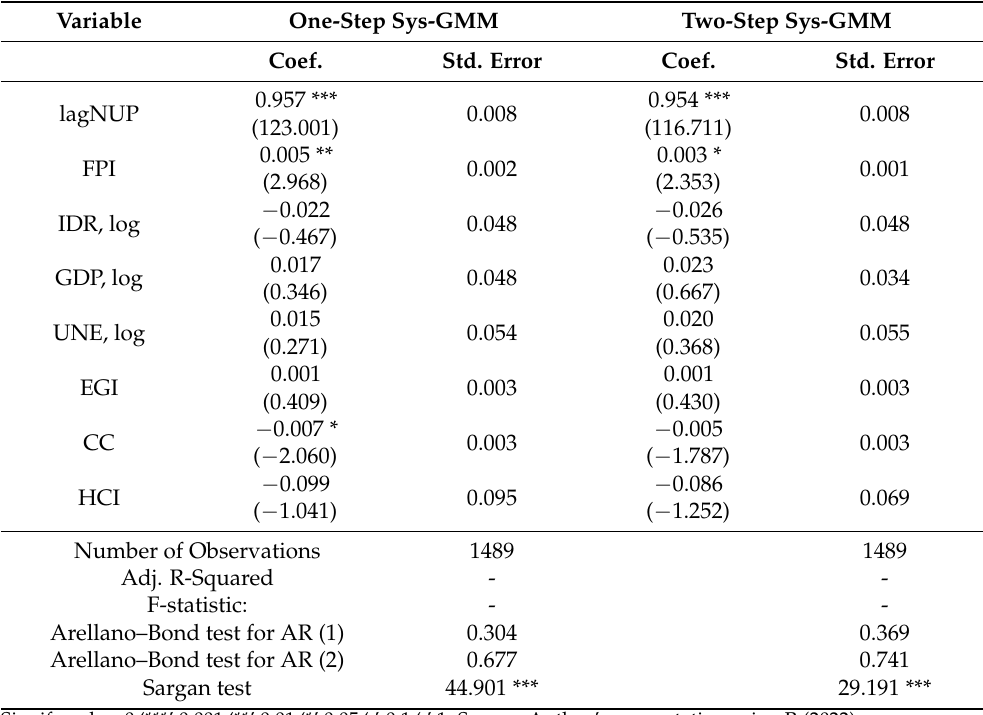
Table 6. Regression results of the sys-GMM estimations for all 57 countries.